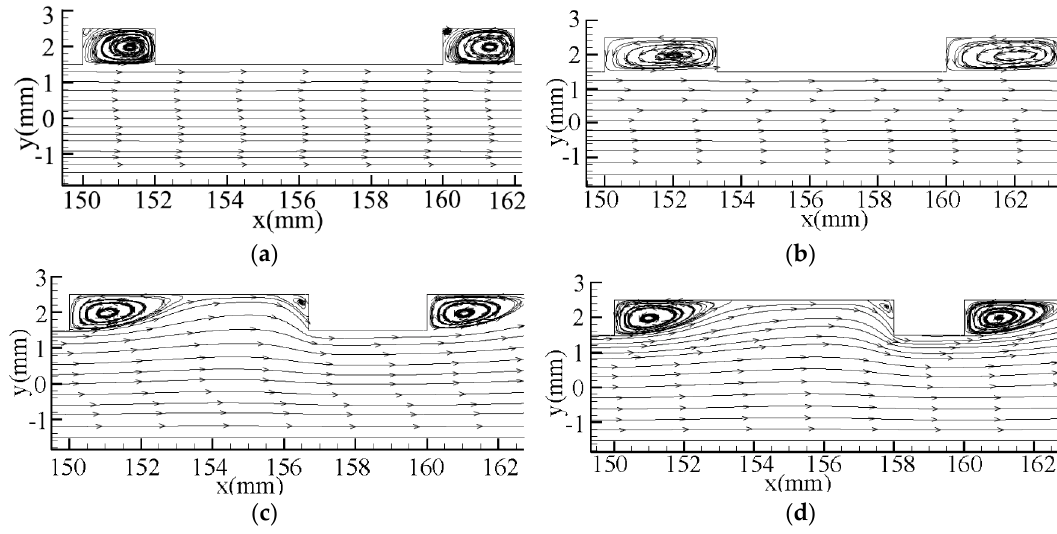
Figure 10. Flow patterns in a narrow channel under a constant L u of 10 mm, H of 1 mm and different R (Re = 3750). ( a ) 1:4, ( b ) 1:2, ( c ) 2:1, ( d ) 4:1.